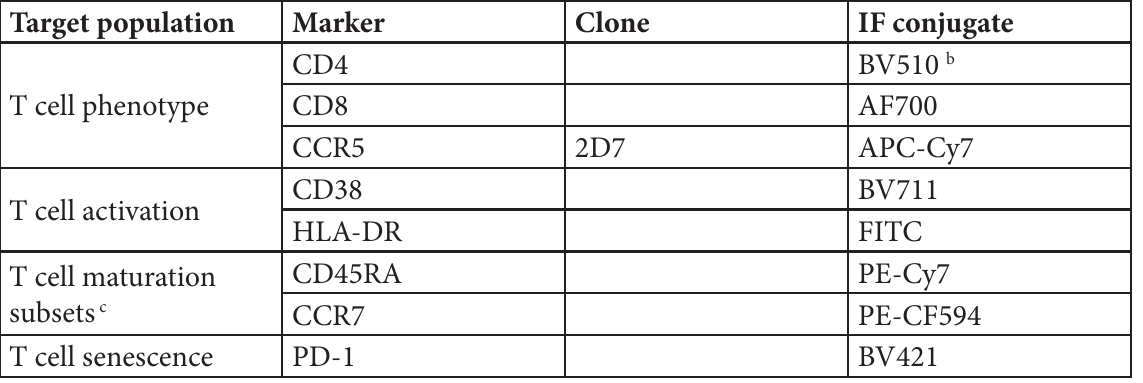
Table 1. List of antibodies a and reagents used for T-cell phenotyping in flow cytometry